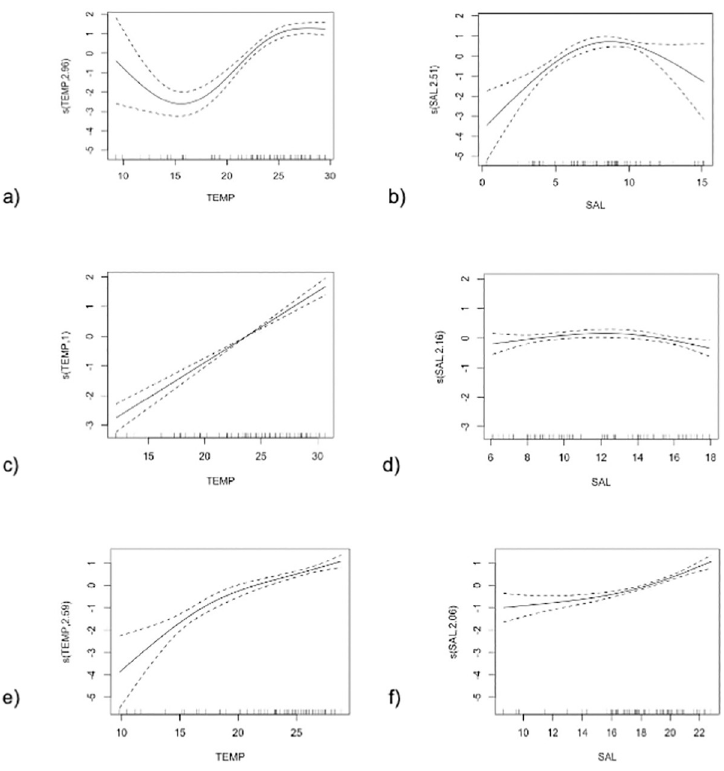
Fig 6. GAM smoothers. The relationship between weekly occurrence of bottlenose dolphins and water temperature (˚C; a, c, e) and salinity (part per thousand, PPT; b, d, f) for each Bay segment. Panel a and b show results from the Upper Bay, c and d show results from the Middle Bay, and e and f show results from the Lower Bay. Explanatory variables are on the x-axes with tick marks showing the distribution of underlying data and the centered, fitted values are on the y-axes. Confidence intervals are shown as dashed lines.